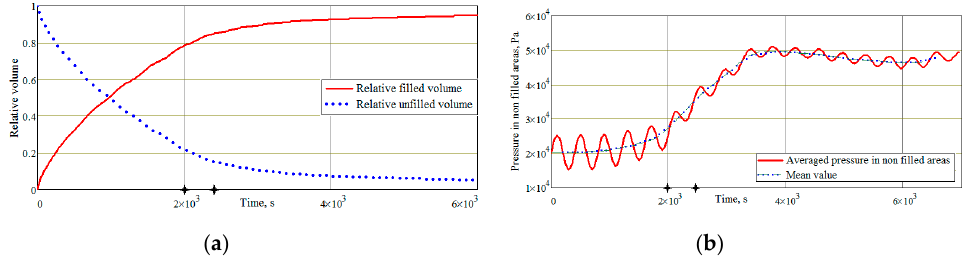
Figure 16. Change of the relative resin filled and unfilled volume ( a ) and the averaged pressure inside the unfilled regions ( b ) during vacuum infusion.